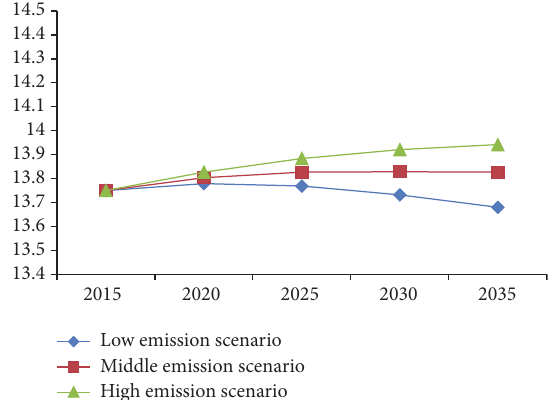
Figure 8: The trends of population in the low, middle, and high emission scenarios (a hundred million).